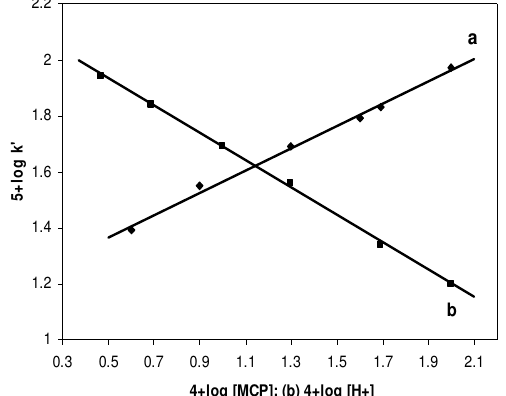
Figure 1. Plot of 5+log k’ versus (a) 4+log [MCP]; (b) 4+log [H + ].